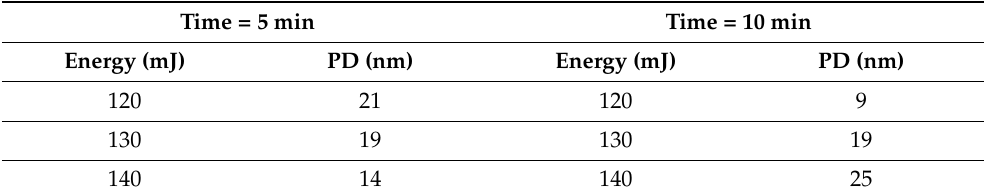
Table 2. Particle diameter obtained with 15 mL of water at different time ablation (retrieved with permission from reference